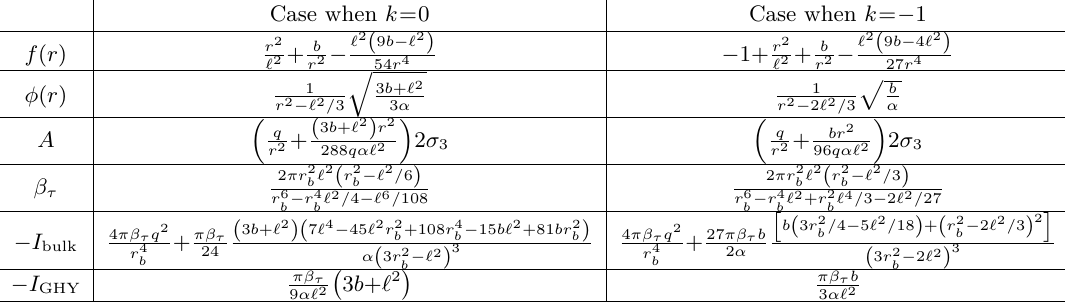
Table 1 . Particular cases of the solution eq. (5.1) for different values of k . When k = 1 , the solution reduces to the one presented in eq. (3.3), modulo a redefinition of the parameters. In all cases, the scalar field remains finite as r → r b , where r b is defined through f ( r b ) = 0 . Moreover, the spacetime is absent of conical singularities if the period of the Euclidean time is β τ . The Weyl tensor in these cases is not globally (anti-)self dual but, rather, asymptotically (anti-)self